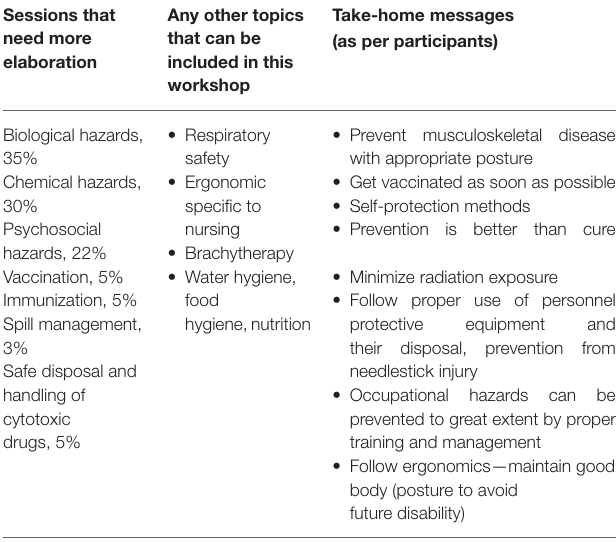
TABLE 2 | Feedback of participants.